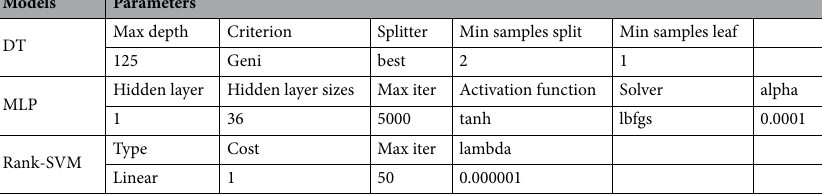
Table 6. Experimental ventilation network multifault location diagnosis model hyperparameter setting.